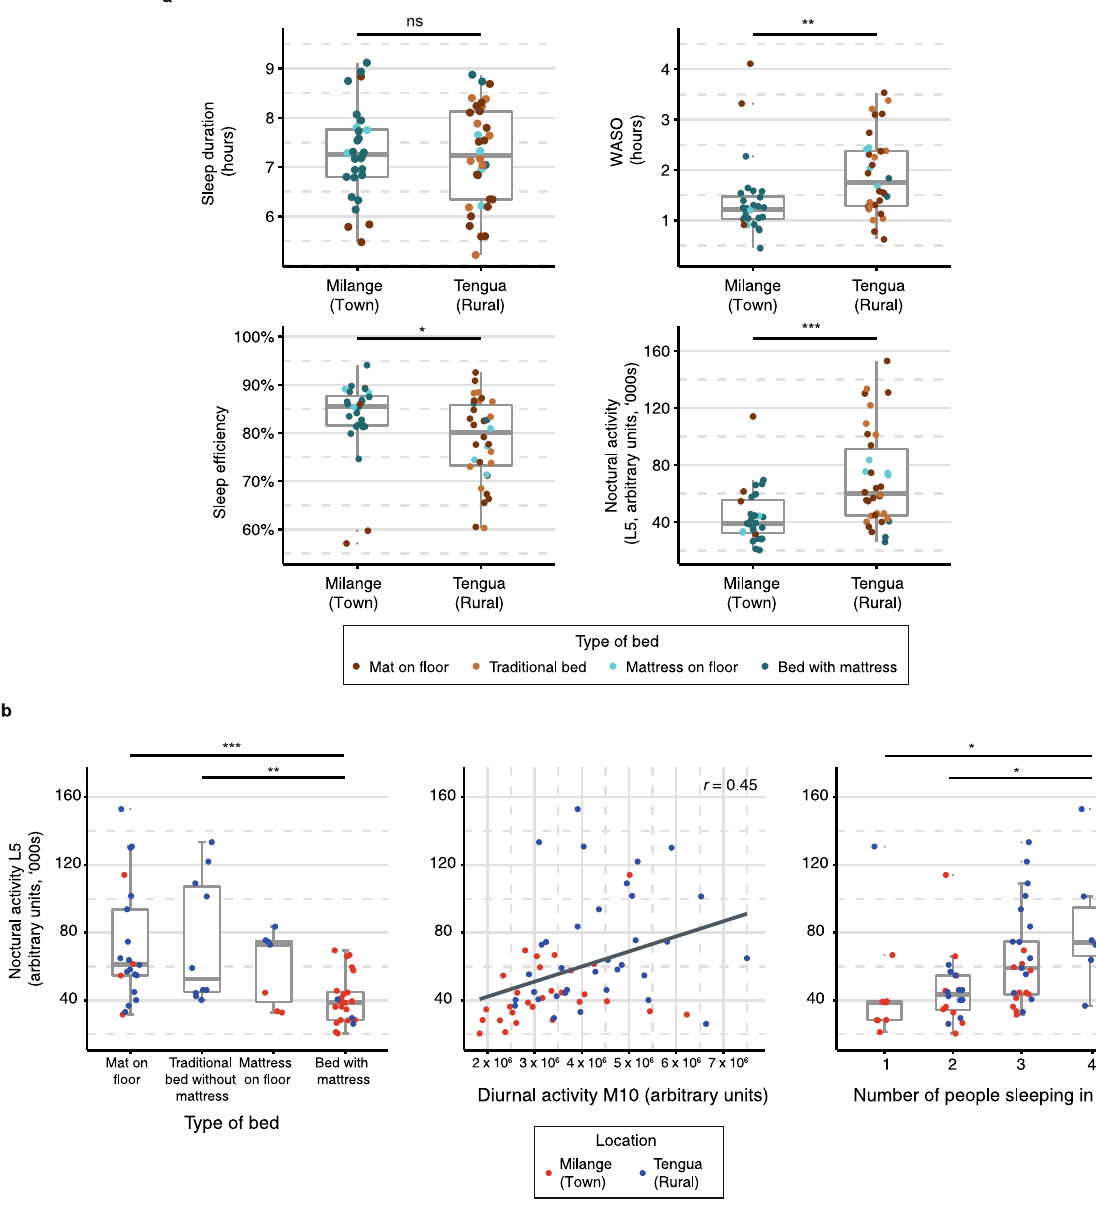
Figure 3. Sleep variables in town and rural settings. ( a ) Sleep variables by location. WASO, sleep efficiency and nocturnal activity L5 significantly differed between Milange and Tengua, though total sleep duration was not significantly different. Type of bed is represented by colour. *** P < 0.001; ** P < 0.01; * P < 0.05, according to Table 1. ( b ) Environmental variables impact nocturnal activity L5. Type of bed (left), amount of diurnal activity M10 (centre) and number of people sleeping in the same room (right) associated with the amount of nocturnal activity across both locations (Milange, red; Tengua, blue). Significance between groups is denoted by Bonferroni corrected post-hoc tests, *** P < 0.001; ** P < 0.01; * P < 0.05. Correlation ( r ) determined significant association between continuous